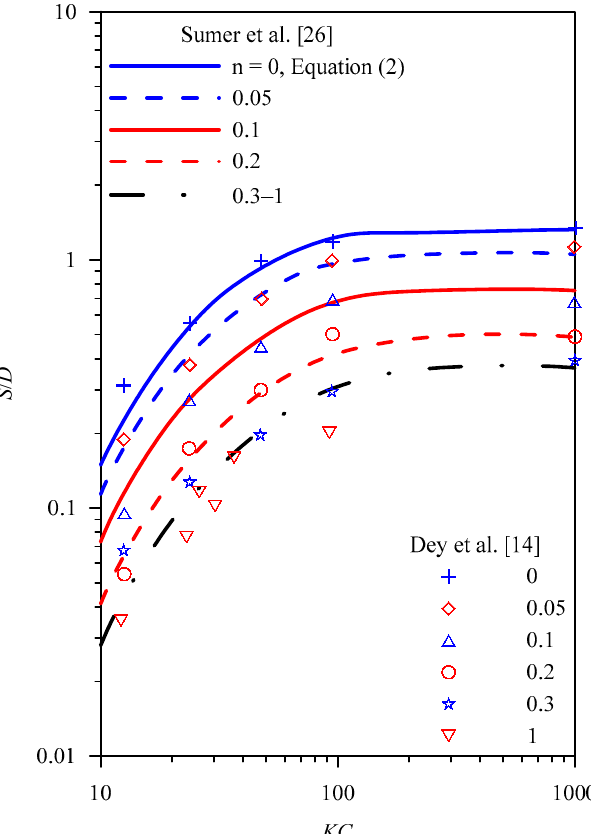
Figure 4. Nondimensional scour depth, S / D , versus Keulegan–Carpenter number, KC number, for different values of clay fraction n in sand–clay mixtures, where the solid line for n = 0 represents Equation (2), given by Sumer et al. [26].